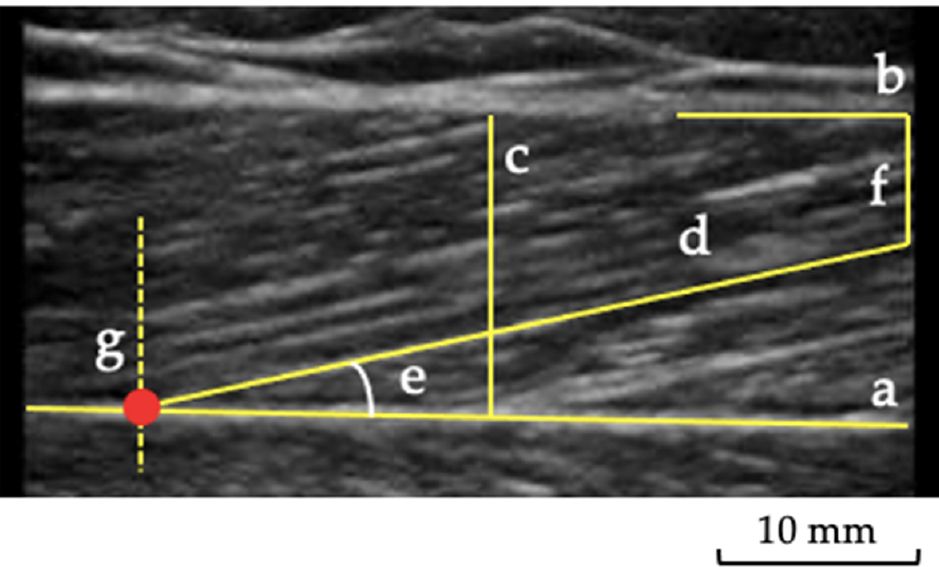
Figure 2. Muscle ultrasonography: a representative image of the gastrocnemius lateralis ultrasound analysis. ( a ) deep aponeurosis; ( b ) superficial aponeurosis; ( c ) muscle thickness; ( d ) fascicle length; ( e ) pennation angle; ( f ) distance between end of fascicle visualization and superficial aponeurosis; ( g ) lines indicating the cross-point between fascicle and deep aponeurosis.